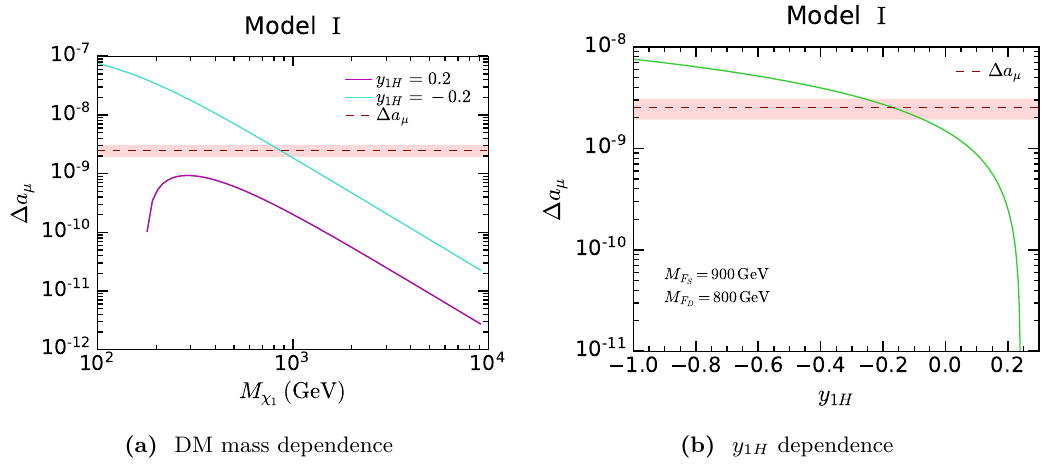
Figure 6. ∆ a µ as a function of (a) the DM mass M χ M ˜ /M F = 1 . 2 ; (b) y 1 H for M F L D the parameters are set to be y 1 = y 2 = λ L = λ 0 indicates the measured value of ∆ a µ , with its error indicated by the red band.